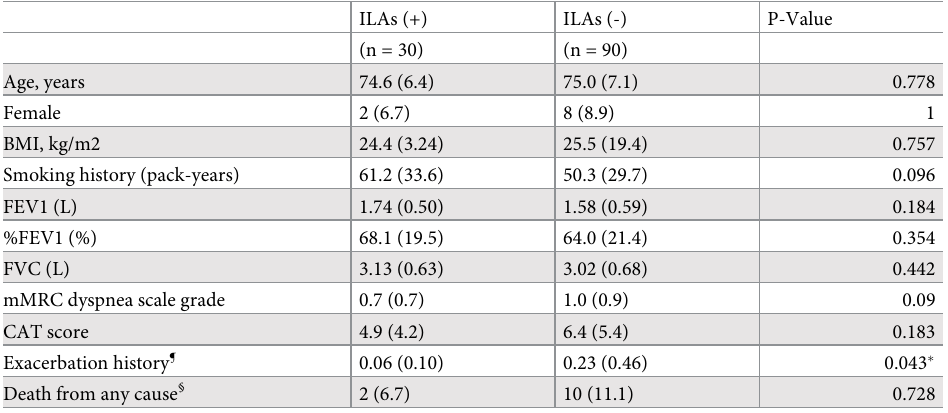
Table 3. Characteristics of the study patients with and without ILAs after 1-to-3 propensity score matching.